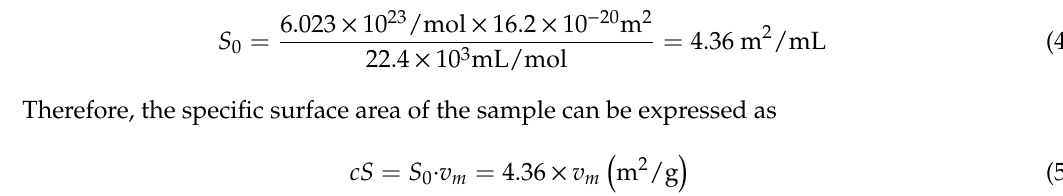
( d ) Oil washing Figure 10. The BET diagrams of interlayer samples after different sample treatment conditions. 0.00 0.05 0.10 0.15 0.20 0.25 0.30 0.350.020.04 0.060.080.100.120.140.160.180.20